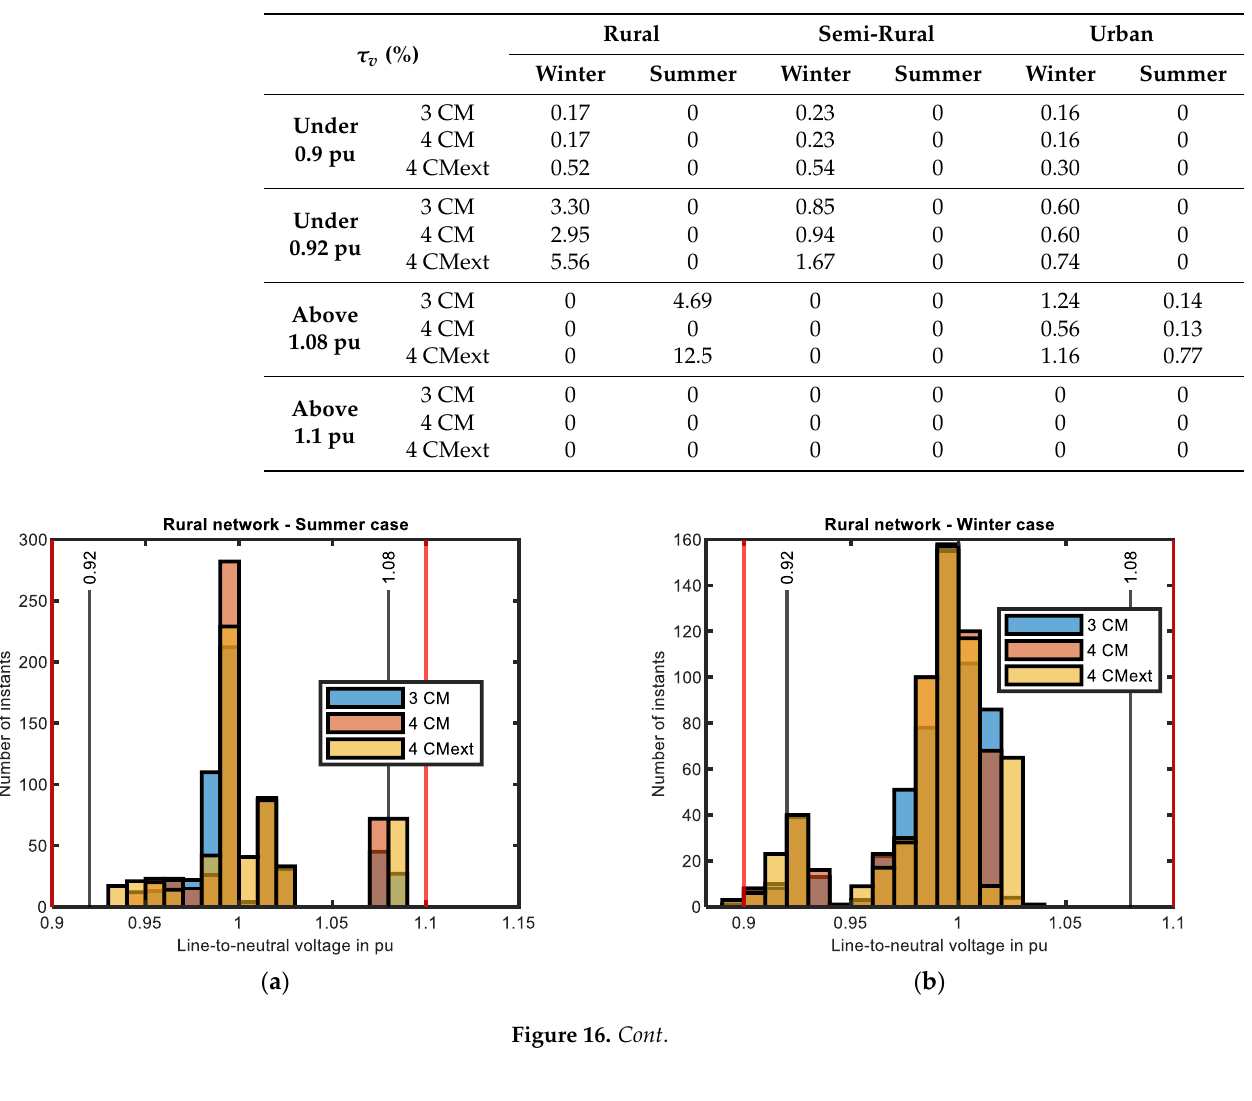
Table 11. τ v ratio (21) in different networks and